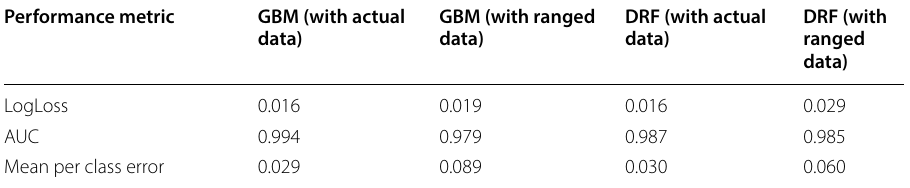
Table 3 Models’ performances during the training phase Performance metric